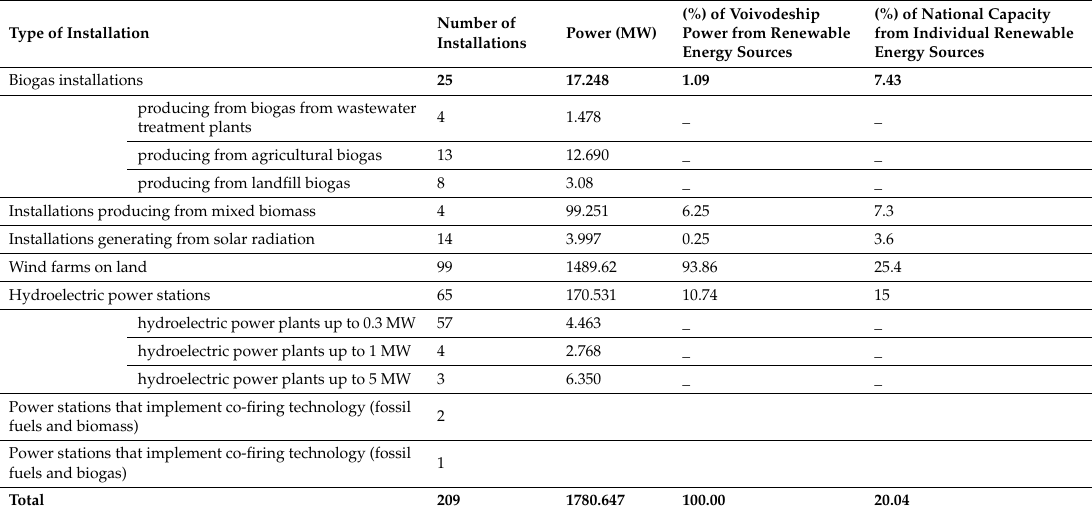
Table 1. Installations of substitutes for conventional energy sources in the studied region.